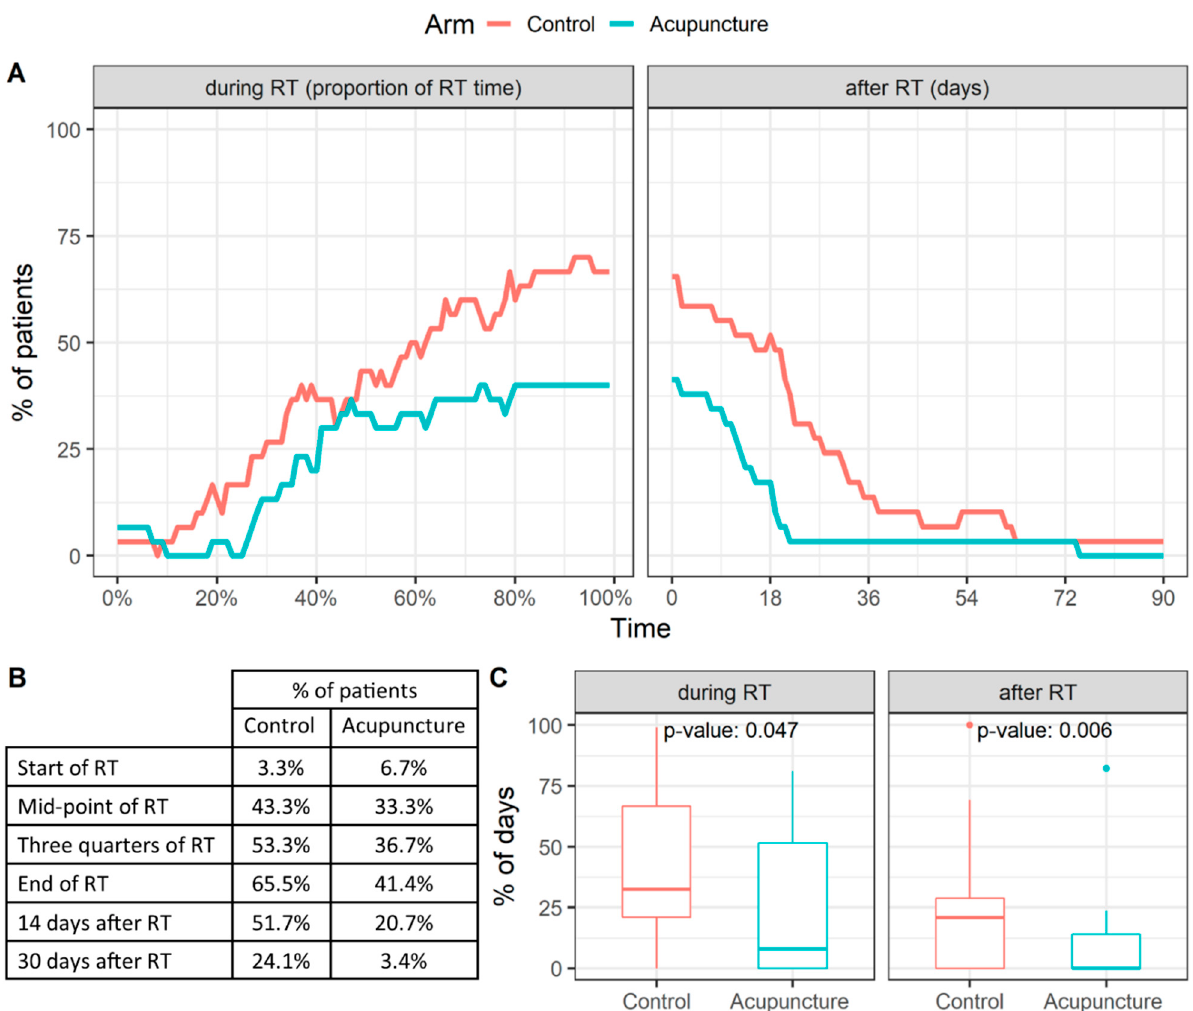
Figure 4. ( A ) Time course and ( B ) the key moments during the treatment of the proportion of patients requiring analgesic therapy. ( C ) The proportion of days when the patients used analgesics.